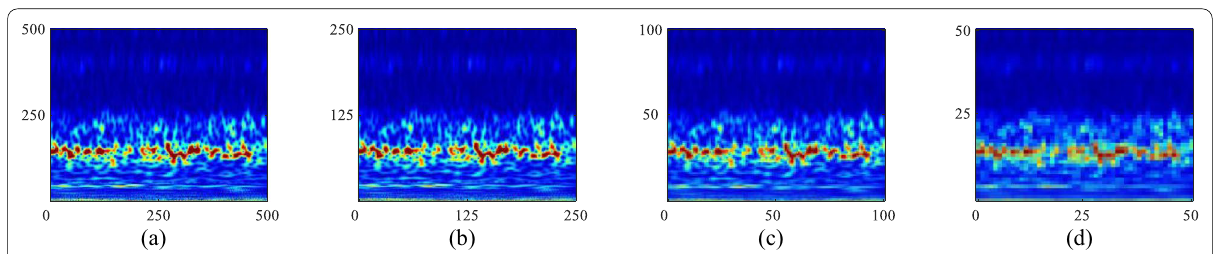
Figure 6 Visualization images of TFRs with four different reduced dimensionalities: (a) R